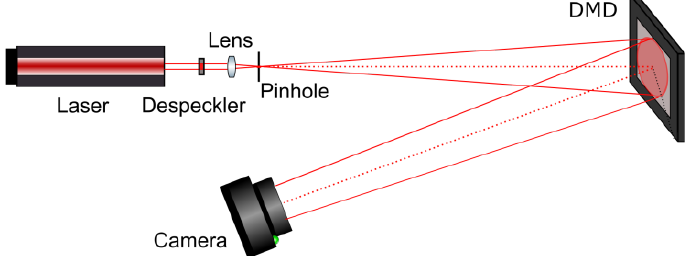
Figure 11. Scheme of the experimental setup for hologram image reconstruction using DMD in divergent beams.